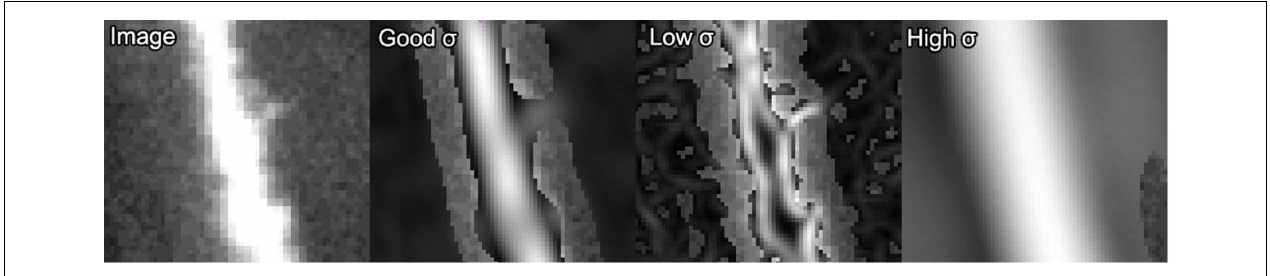
inappropriately small value of σ and the response with an overly large σ . Areas where the original image show through indicate values of zero for ρ ( x ).